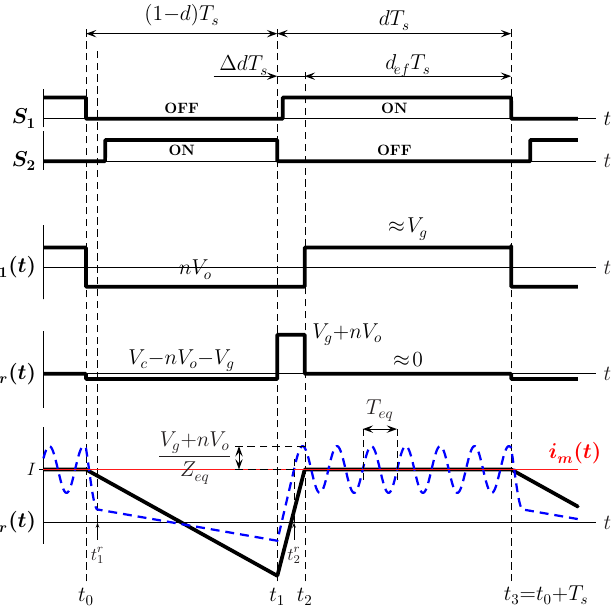
Figure 3. Main curves for circuit in Figure 2: i r ( t ) is plotted for the ideal case (solid) and when parasitic elements are included